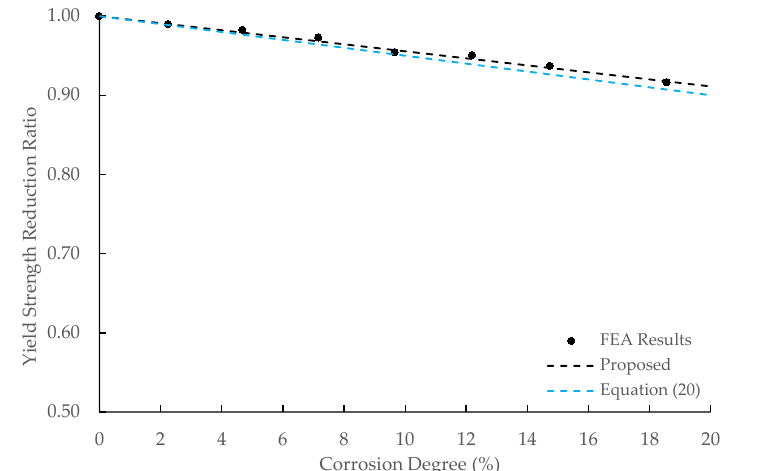
Figure 16. Relationship between corrosion degree and yield strength reduction ratio.